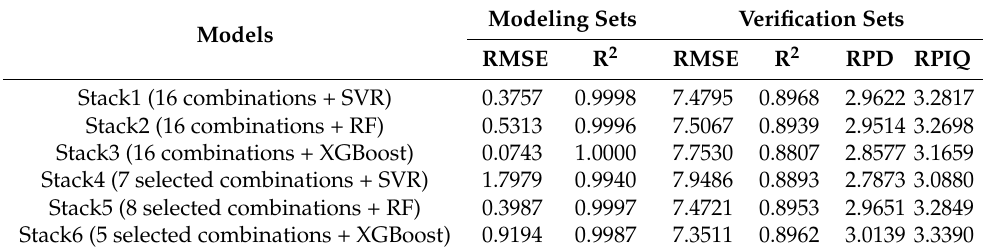
Table 5. Accuracy comparison of six stack models.